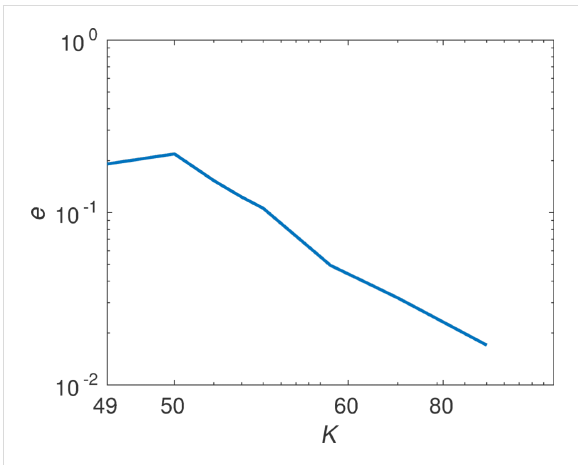
Figure 5: Convergence of the T-matrix calculation with the increase of the number of plane wave illuminations. The minimum number of illu- minations necessary to solve for all the unknown entries of the T-matrix for the multipole order N = 4 is 48.